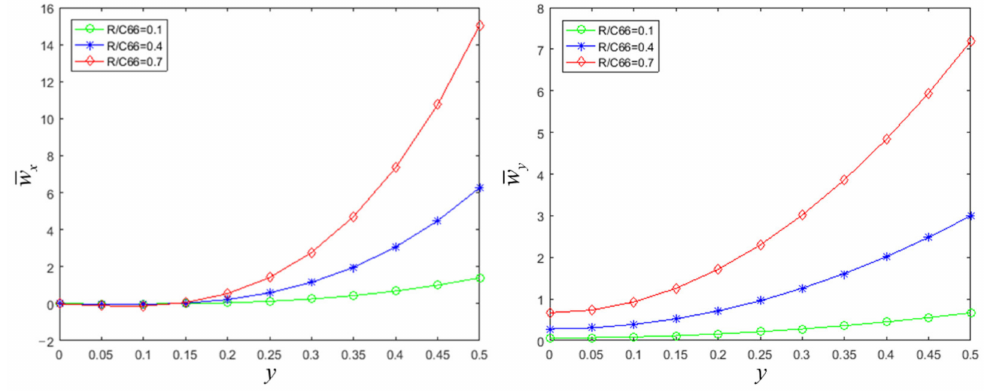
Figure 3. Normalized displacements of phason field versus y at x =